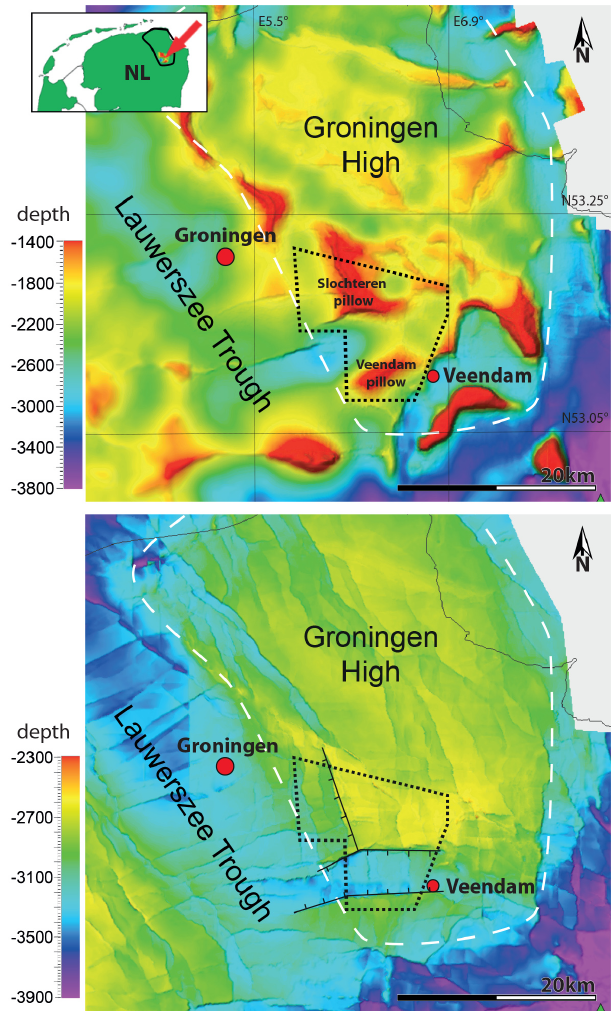
Figure 1. (a) Top Salt map from the Groningen High (outline marked by white dotted line) and surrounding areas (modified af- ter Strozyk et al., 2014). The black dotted line indicates the out- lines of 3-D seismic volumes covering the study area; (b) base Salt map from the Groningen High and surrounding areas (modified af- ter Strozyk et al., 2014). Major normal faults (offset <100m) in the study area are